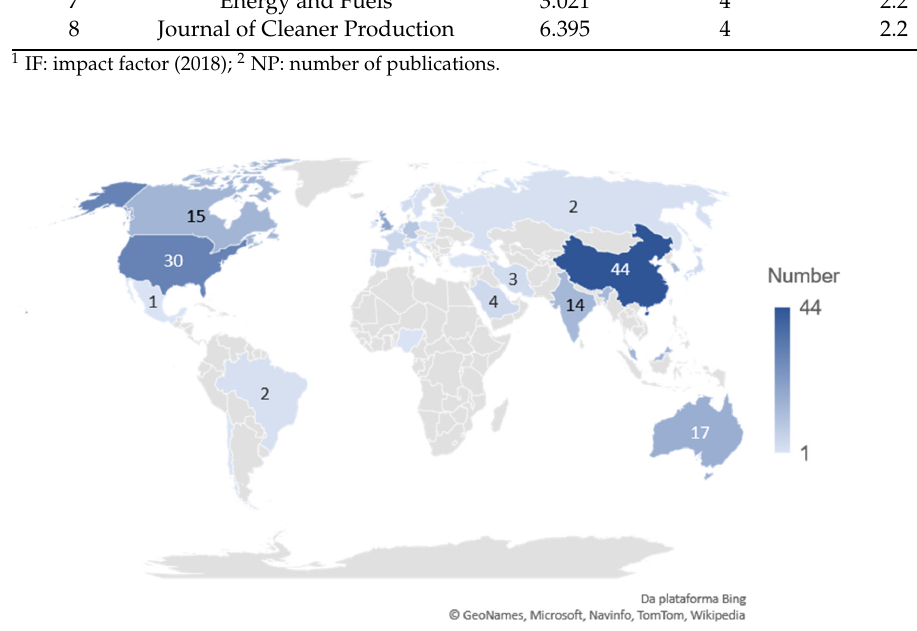
Figure 9. Country distribution of reviews in the field of CCU. Table 6. Most productive institutions regarding the scope of this work.